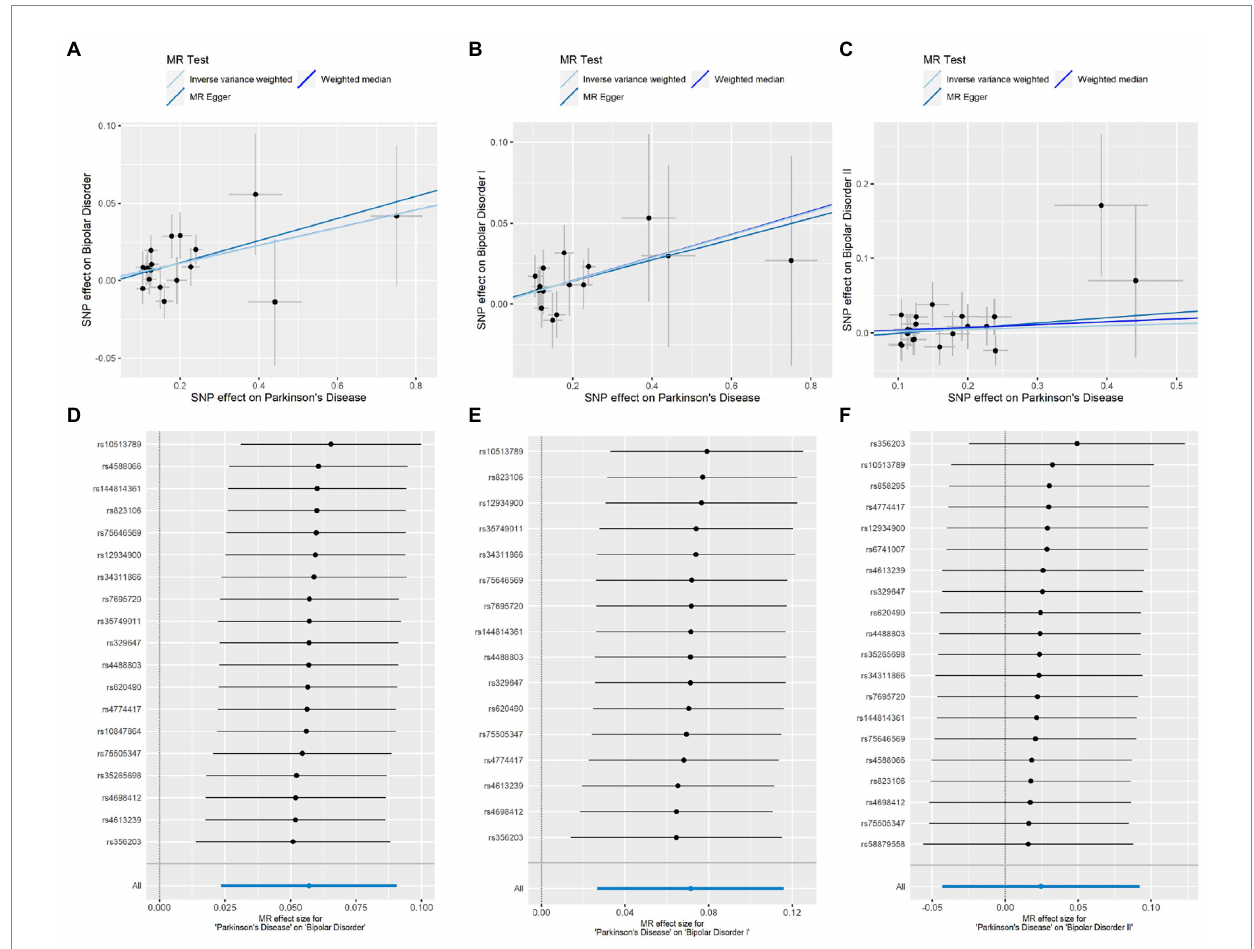
FIGURE 2 Causal effect estimation of PD on BD. (A–C) Scatterplots of potential effects of SNPs on BD (BD/BD I/BD II) and PD. Corresponding slope of each represents the estimated MR effect of each method. (D–F) Leave-one-out-sensitivity forest plots of PD-BD (BD/BD I/BD II)